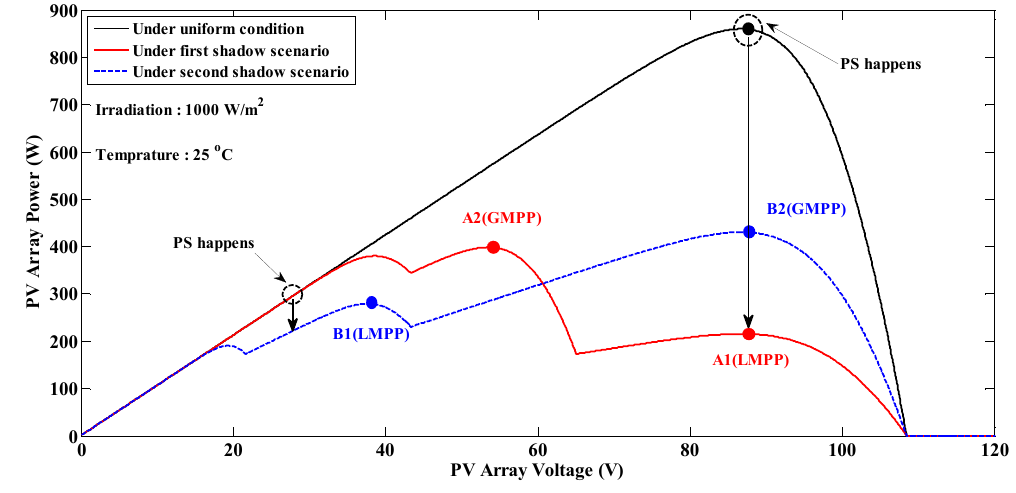
Figure 6. The failed MPPT in PS condition.